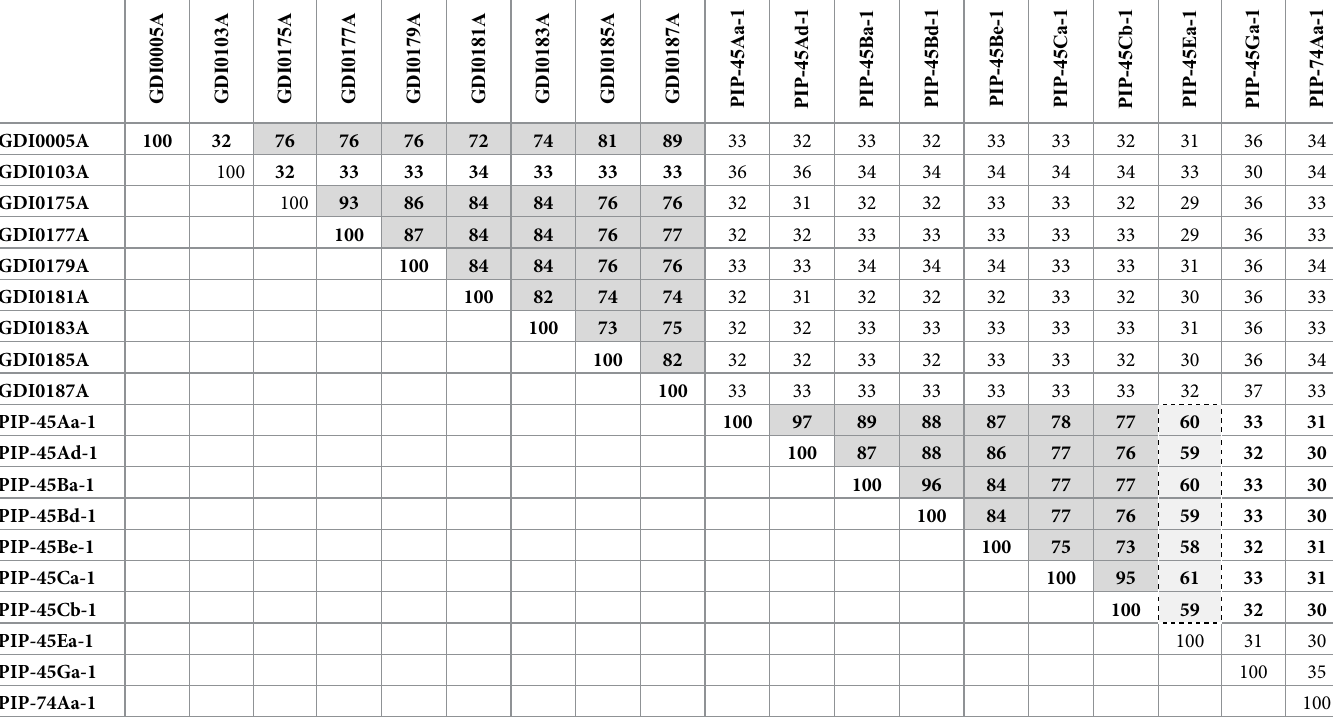
Table 1. Percentage of amino acid identity between members of the PIP45, PIP75 and the novel discovered GDI0005A protein families.